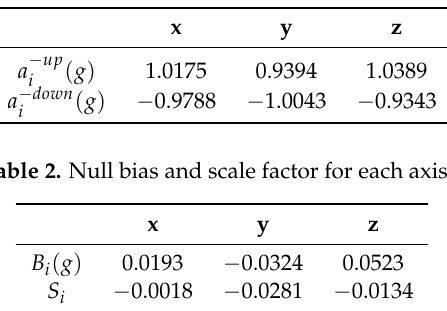
Table 1. Averages of the six key positions.